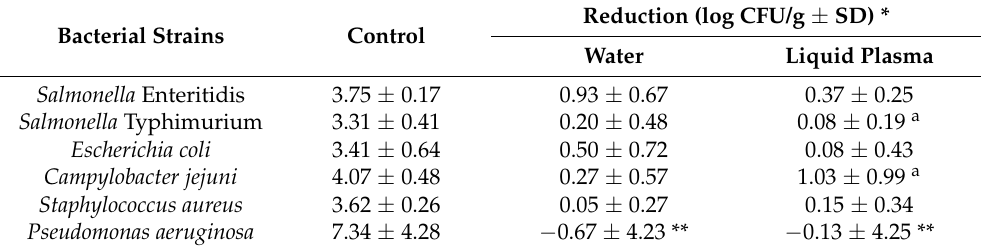
Table 1. Reduction in the bacteria on pork.